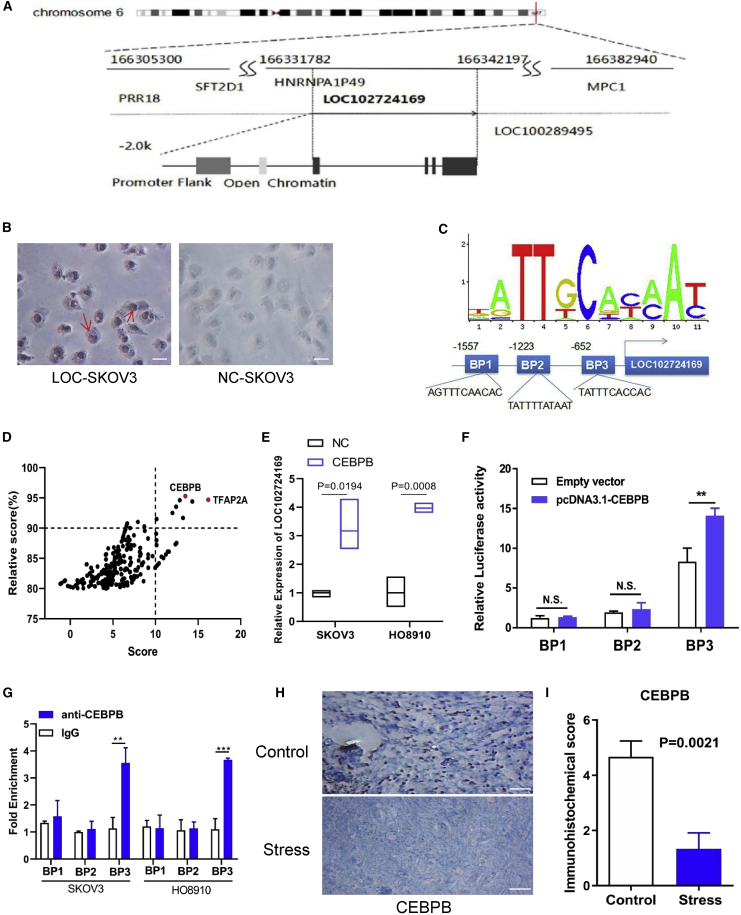
Identification of lncRNA LOC102724169 transcriptionally regulated by CEBPB(A) Gene map of LOC102724169, a lncRNA on human chromosome 6q27. (B) RNA ISH assay suggested that LOC102724169 was mostly located in the nucleus of SKOV3 cells. Original magnification, ×200; scale bars, 5 μm). (C) JASPAR (http://jaspar.genereg.net/) was used to predict sites of putative CEBPB binding motif in the LOC102724169 promoter region. (D) Relative score and score of transcription factors predicted by JASPAR. (E) Relative expression of LOC102724169 in both SKOV3 and HO8910 cells transfected with CEBPB or control plasmid. (F) Dual-luciferase reporter assays examining the relative luciferase activities, which show a marked CEBPB binding activity in the BP3 site of LOC102724169. (G) ChIP assays of the enrichment of CEBPB on the LOC102724169 promoter relative to control IgG in both SKOV3 and HO8910 cells. (H) CEBPB expression levels measured in tumor tissues of stressed mice and non-stressed mice by immunohistochemistry analysis. Original magnification, ×200; scale bars, 5 μm). (I) Immunohistochemical score of CEBPB in stressed mice and matched control group. ∗∗p < 0.01. Statistical differences were calculated using a two-tailed Student’s t test. Data are represented as mean ± SEM. ISH, in situ hybridization; BP3, binding position 3.